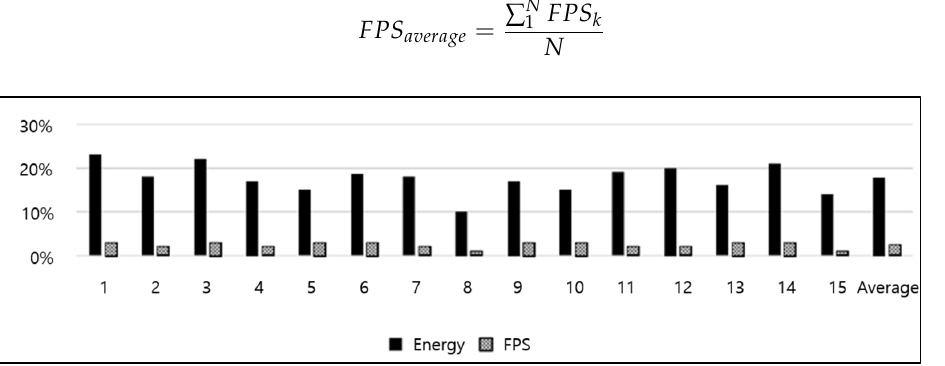
Figure 11. Energy reduction rate and FPS increase rate of the proposed method for the default frequency governor while running 15 workloads. frequency governor while running 15